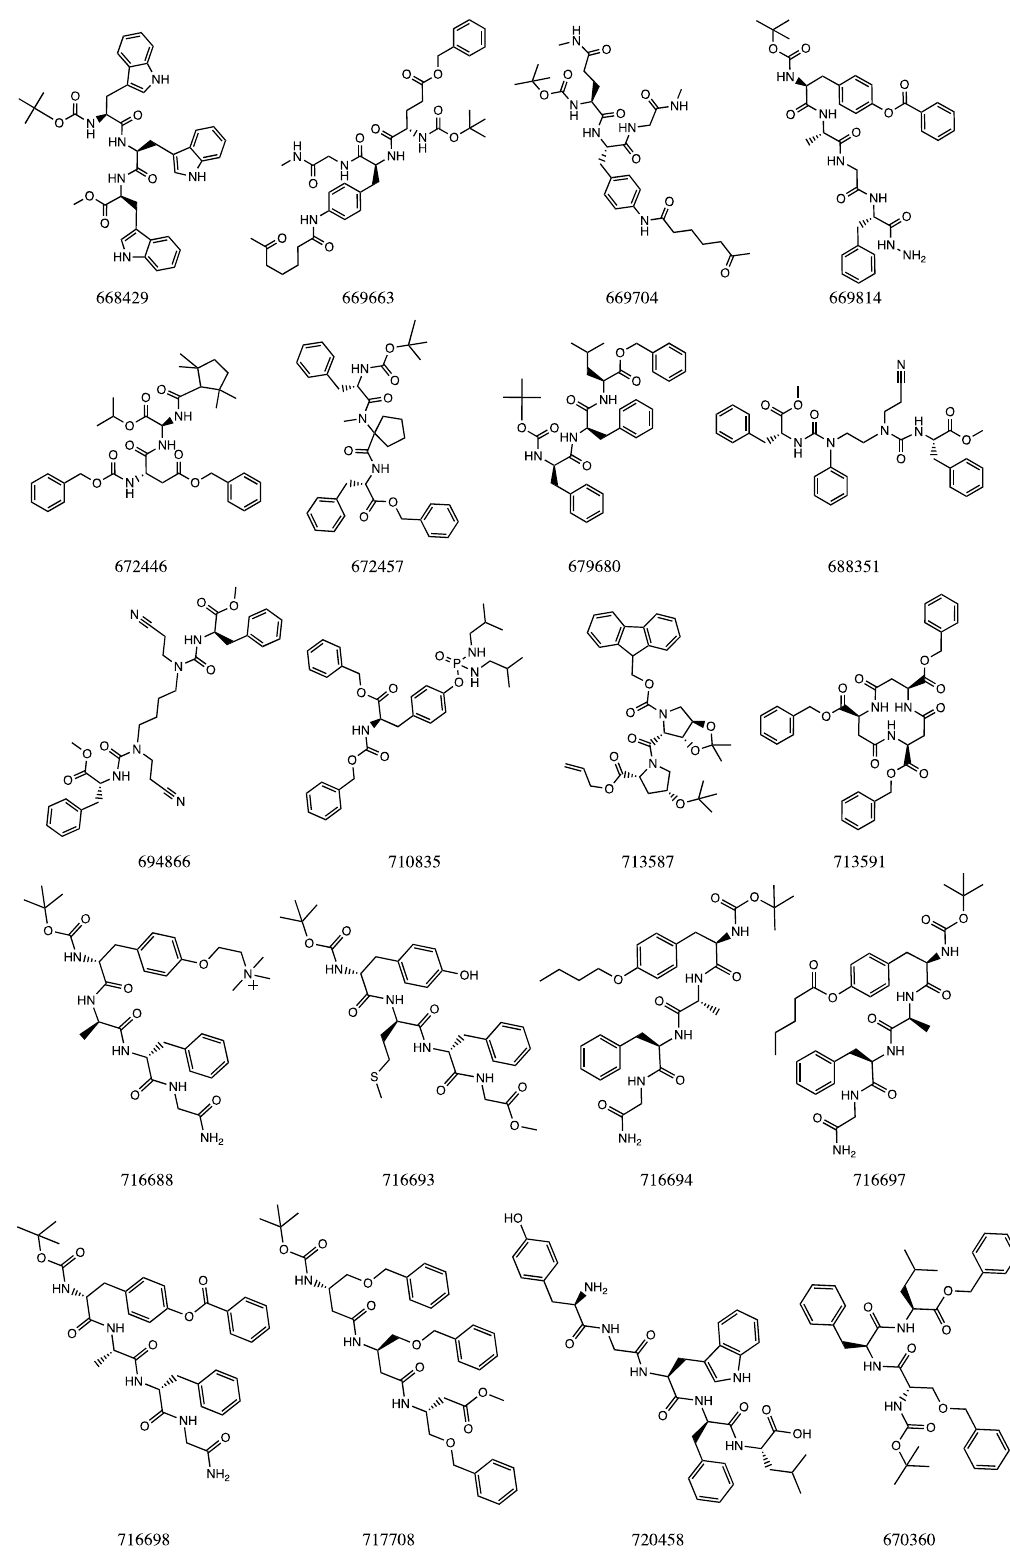
Figure 4. Chemical structures of the top-scored NCI compounds obtained by the ligand-based analysis (the number reported below each structure represents the NSC number in the NCI database).